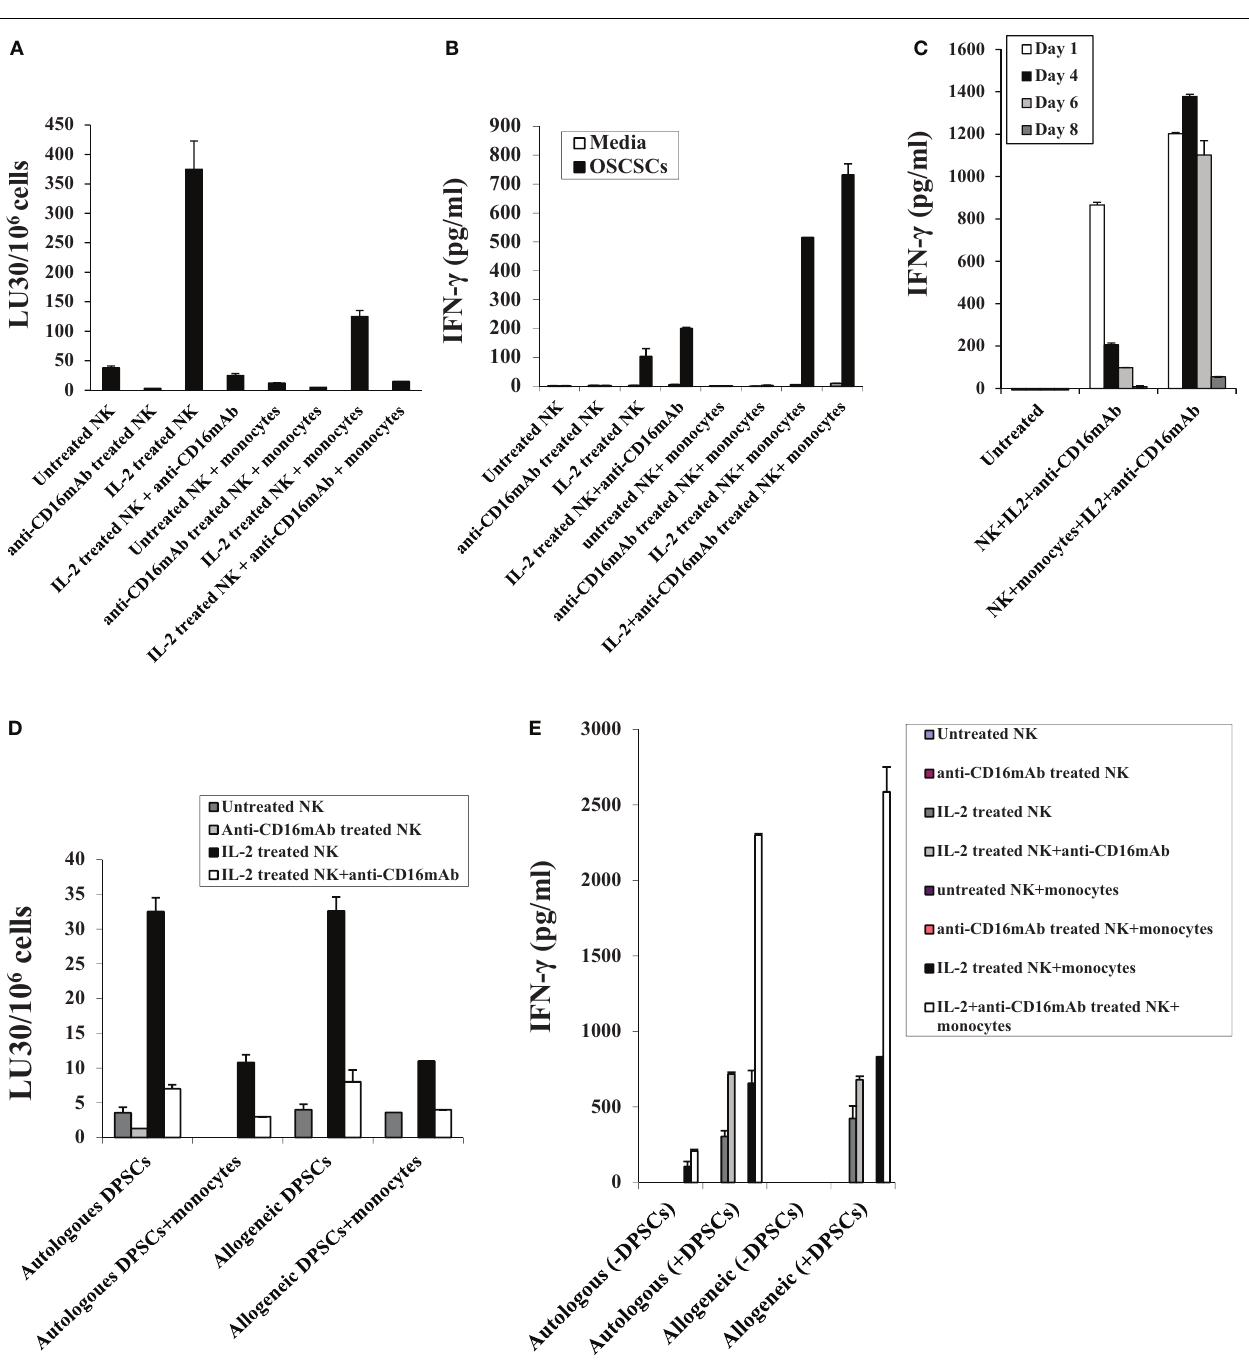
FIGURE 2 | Monocytes induce split anergy in NK cells resulting in a significant loss of NK cell cytotoxicity against OSCSCs and DPSCs and increased secretion of IFN- γ by the NK cells . NK cells were purified from healthy donors and left untreated or treated with IL-2 (1000units/ml), anti-CD16 mAb (3 µ g/ml), or the combination of IL-2 (1000units/ml) and anti-CD16 mAb (3 µ g/ml) in the presence or absence of autologous monocytes (1:1 ratio of NK:monocytes) for 24h, after which they were washed and added to 51 Cr-labeled OSCSCs in a 4-h chromium release assay. Percent cytotoxicity was obtained at different effector to target ratio, and the